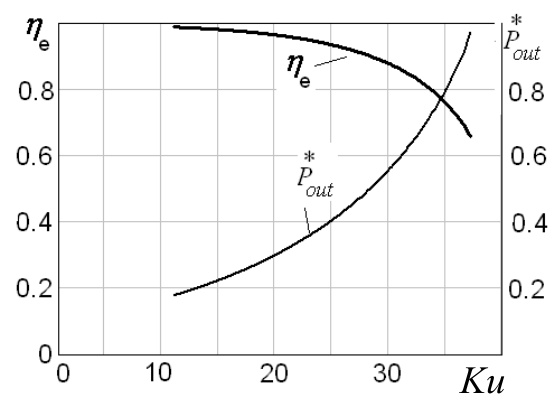
Figure 15. Dependences of the gain on the cutoff factor for resotrodes and IOTs .